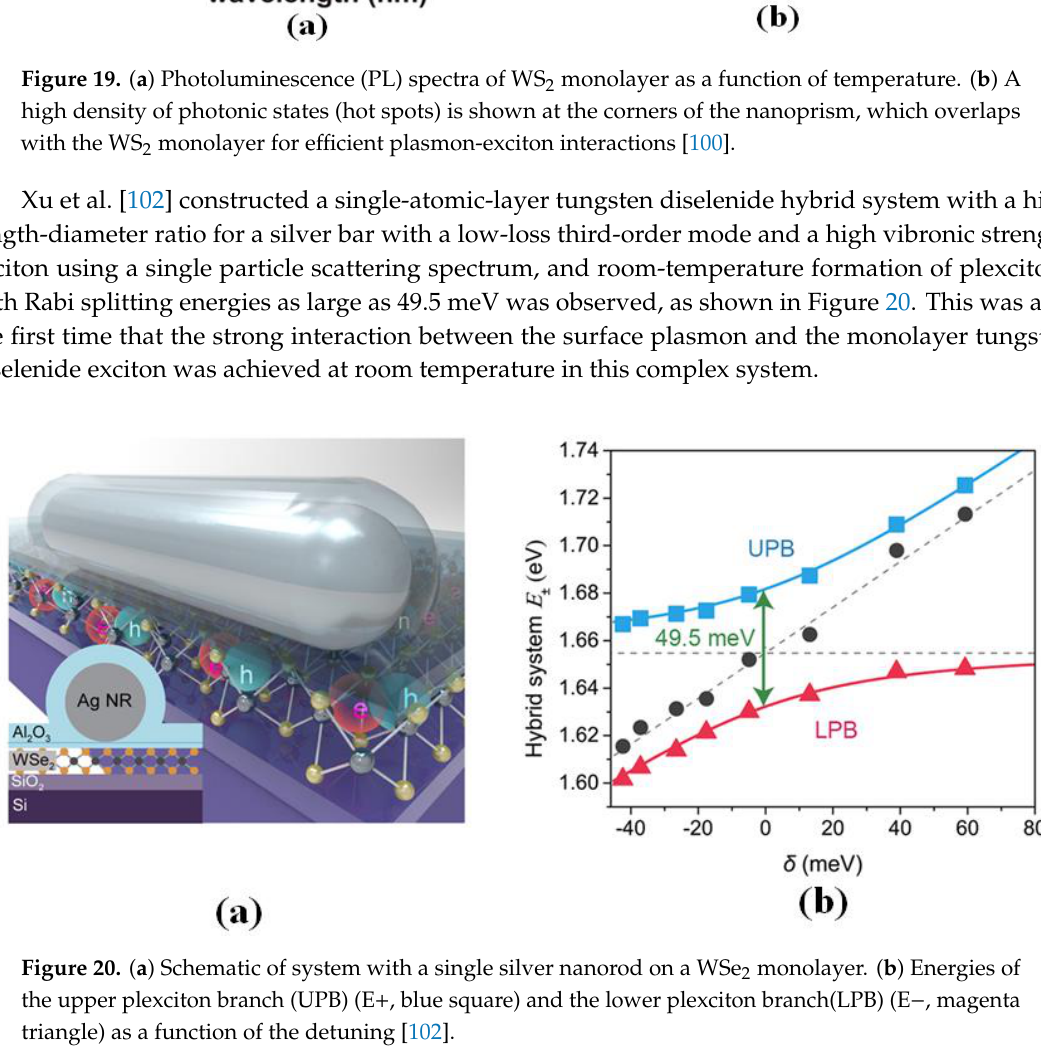
Figure 19. ( a ) Photoluminescence (PL) spectra of WS 2 monolayer as a function of temperature. ( b ) A high density of photonic states (hot spots) is shown at the corners of the nanoprism, which overlaps with the WS 2 monolayer for efficient plasmon-exciton interactions [100].